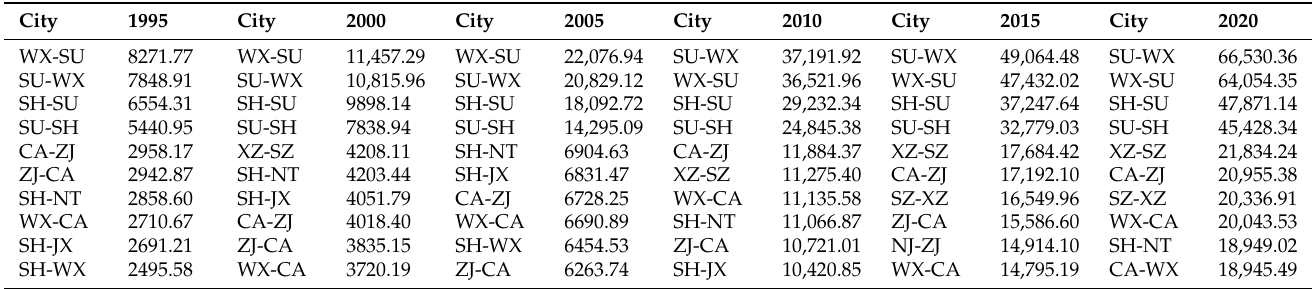
Table 1. The List of the top 10 cities for land pressure network gravitational intensity in the Yangtze River Delta region